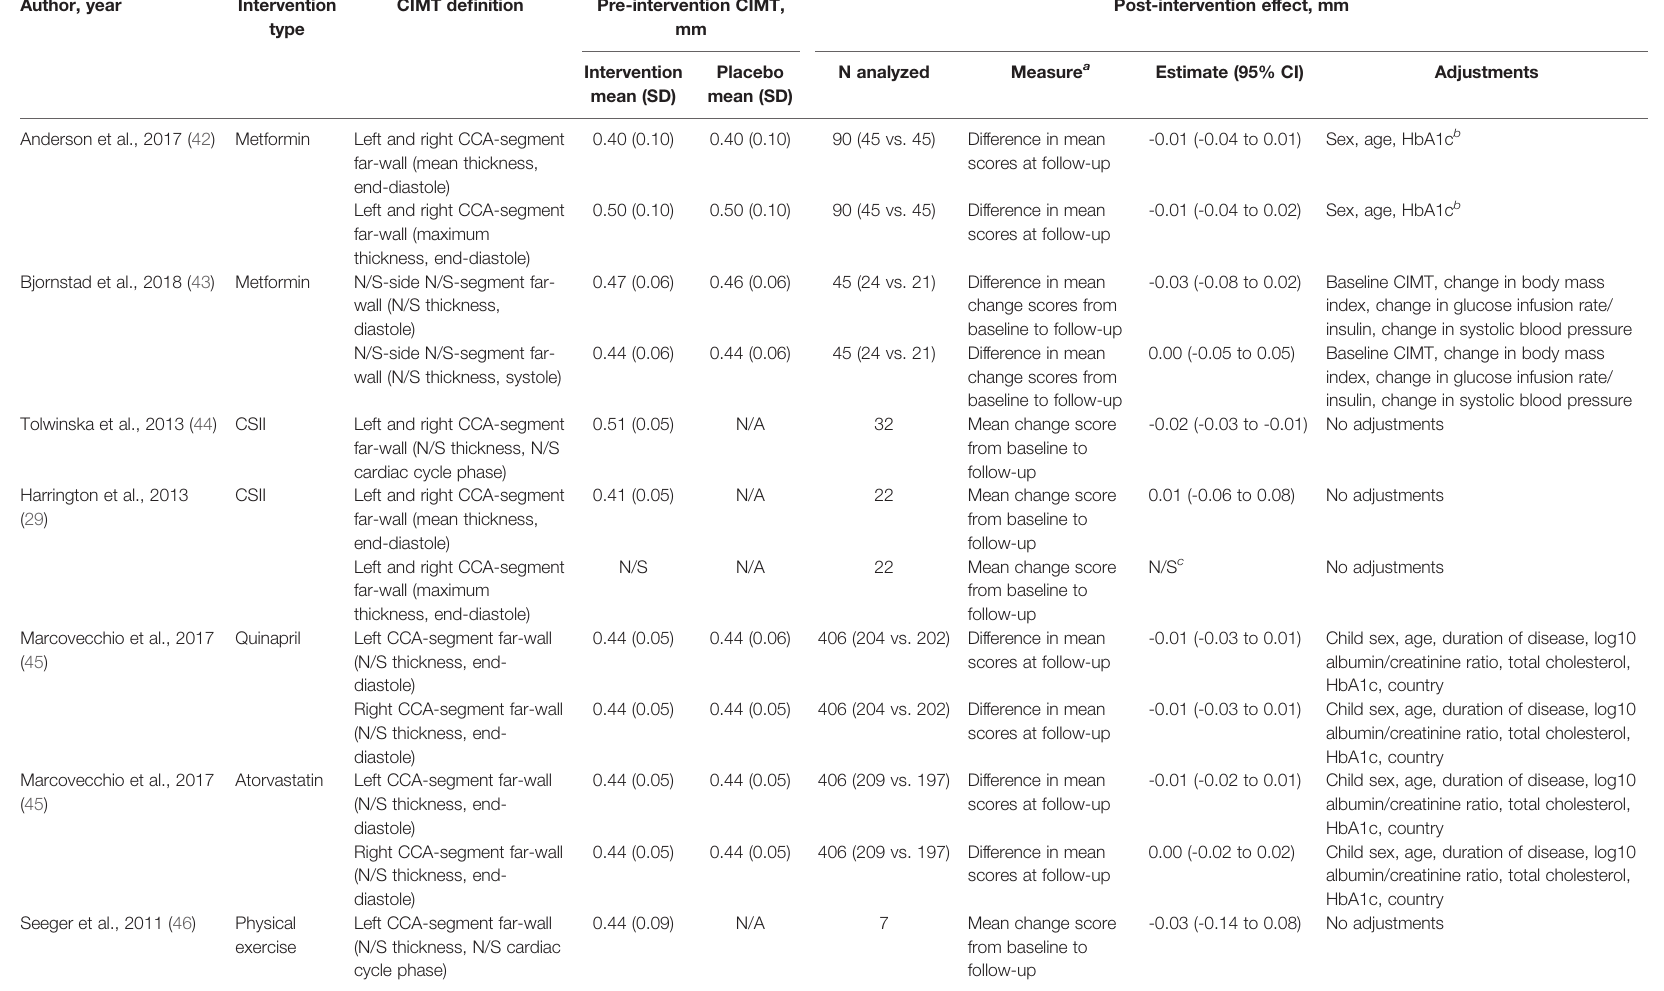
TABLE 3 | The effect of interventions on CIMT in children with type 1